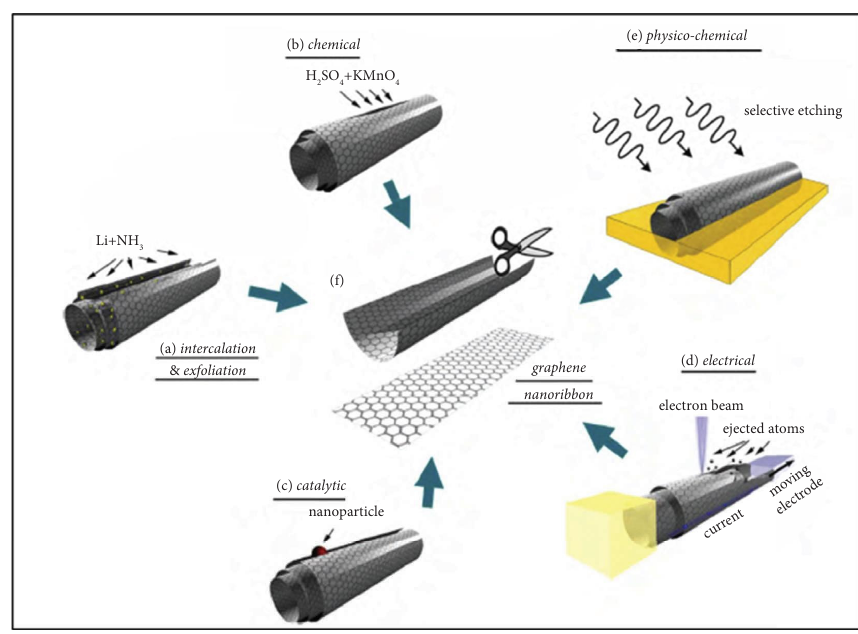
Figure 16: Methods of unzipping carbon nanotubes [67].